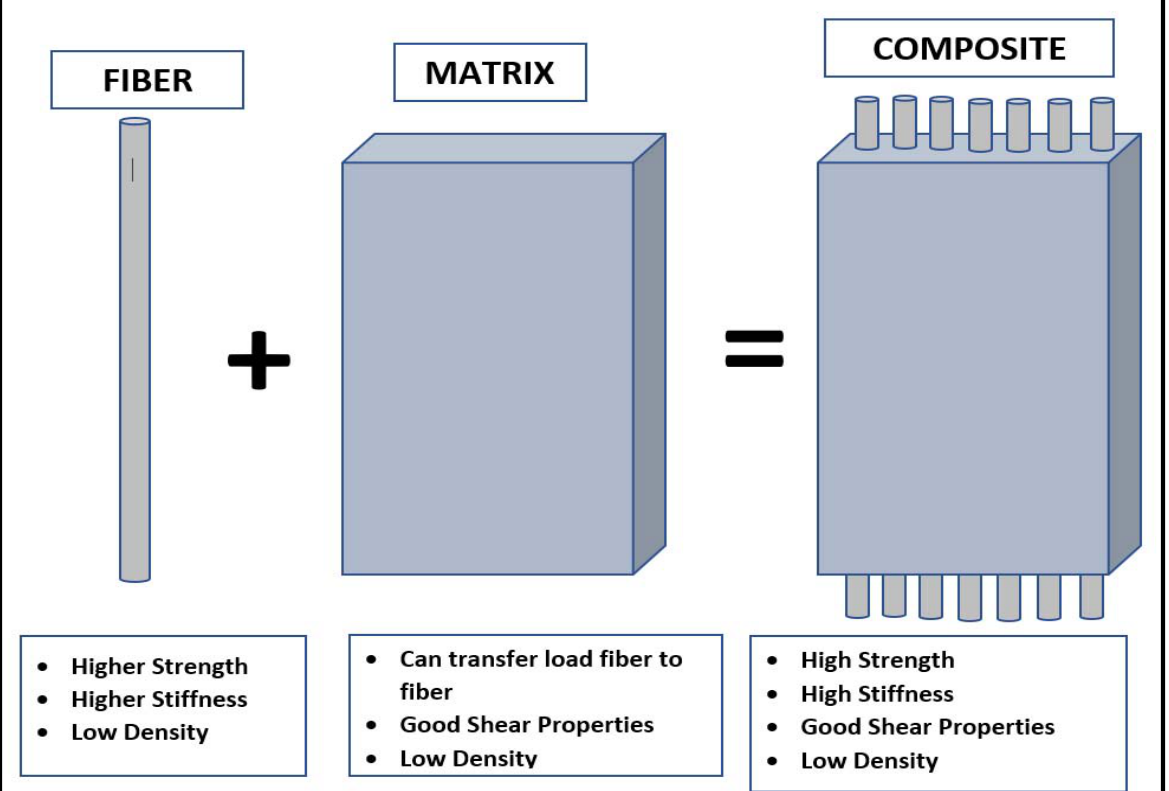
Figure 8. Schematic illustration of fiber-matrix mixture as composite material.